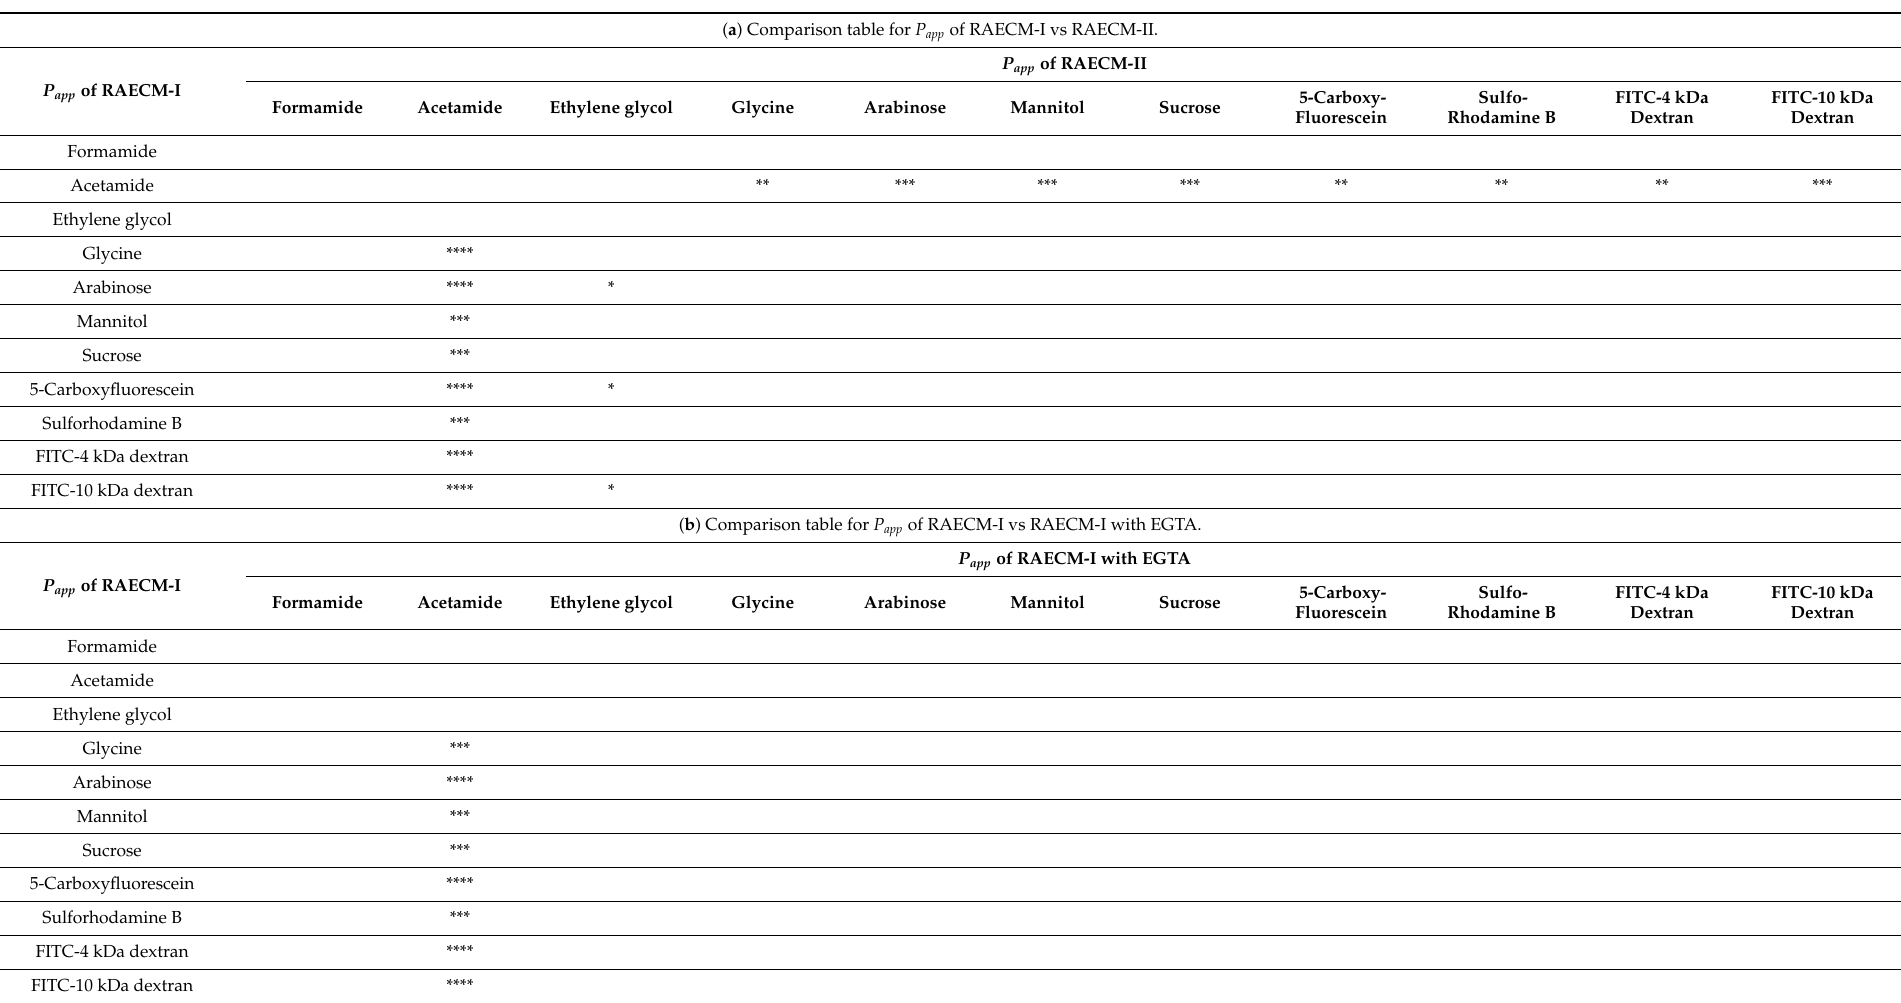
Table A2. Comparisons for P app of RAECM-I vs -II with or without EGTA based on three-way ANOVA and post-hoc Tukey’s multiple comparisons. No entry denotes no significance between the two P app . Comparisons with adjusted p values < 0.05 are listed. **** denotes p < 0.0001, *** denotes p < 0.001, ** denotes p < 0.01 and * denotes p < 0.05. ( a ) Comparison table for P app of RAECM-I vs RAECM-II.